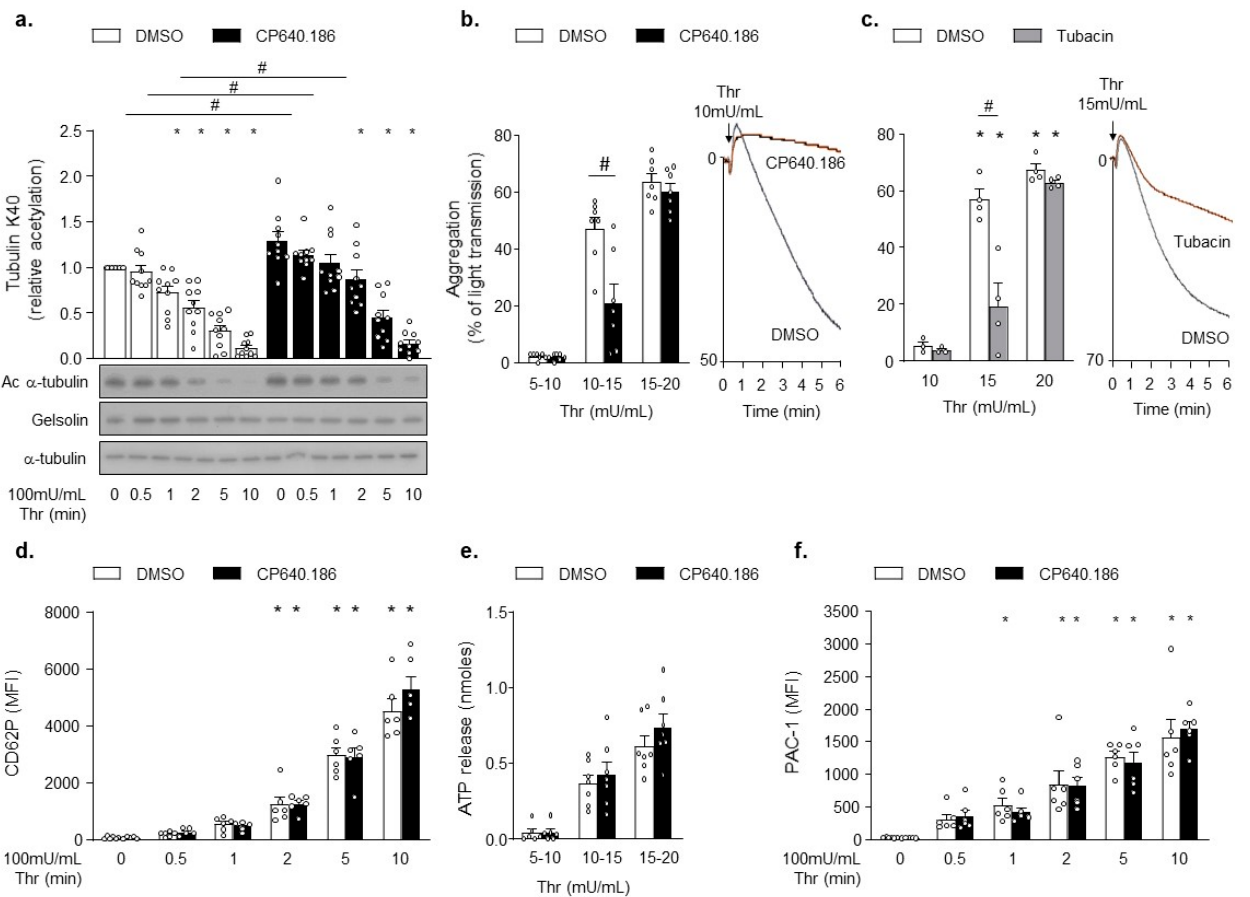
Figure 2. CP640.186-induced ACC inhibition increases tubulin acetylation levels and impairs platelet aggregation. ( a , b , d , f ) Washed human platelets were pre-incubated for 2 h with dimethyl sulfoxide (DMSO) or CP640.186 (60 µ M) or ( c ) for 1 h with DMSO or tubacin (10 µ M), before being stimulated with thrombin (Thr). ( a ) Platelets were stimulated with 100mU/mL Thr at different time points. Whole platelet lysates were subjected to western blot analysis and probed with acetyl α − tubulin (Ac α -tubulin), α -tubulin, or gelsolin antibodies. Data were expressed as means ± SEM ( n = 10); * p -value ≤ 0.05 in relation to unstimulated conditions. # p -value ≤ 0.05 in relation to DMSO conditions. Data were analyzed using 2 − way ANOVA (analysis of variance). ( b , c ) Aggregation was analyzed by turbidimetry (Chrono-Log) in platelets stimulated with various Thr concentrations. Profile is shown on the right. Data were expressed as means ± SEM ( n = 7). # p -value ≤ 0.0001 in relation to DMSO conditions. Data were analyzed using 2 − way ANOVA. ( d ) P-selectin (CD62P) exposure was analyzed, by flow cytometry, in platelets stimulated with 100mU/mL Thr at various time points. Data were expressed as means ± SEM ( n = 6). * p -value ≤ 0.05 in relation to unstimulated conditions. Data were analyzed using 2 − way ANOVA. ( e ) Dense granule secretion was assessed following addition of luciferase-luciferin reagent in platelets stimulated with various Thr concentrations. Data were expressed as means ± SEM ( n = 7). Data were analyzed using 2 − way ANOVA. ( f ) Platelets were stimulated with 100mU/mL Thr at various time points, while α IIb β 3 activation (PAC-1) was detected by flow cytometry. Data were expressed as means ± SEM ( n = 6). * p -value ≤ 0.05 in relation to unstimulated condition. Data were analyzed using 2 − way